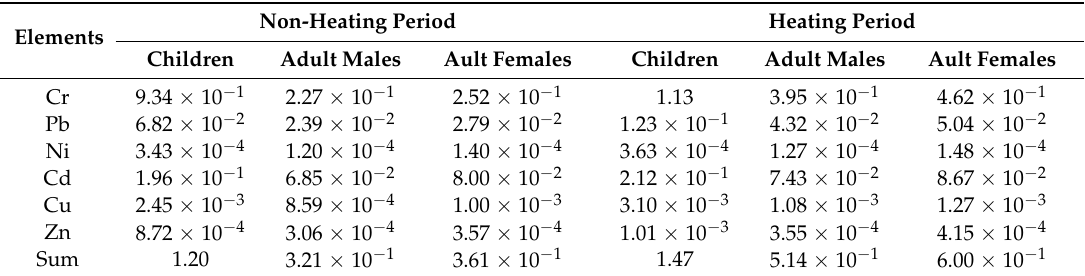
Table 9. The non-carcinogenic risks of heavy metals via